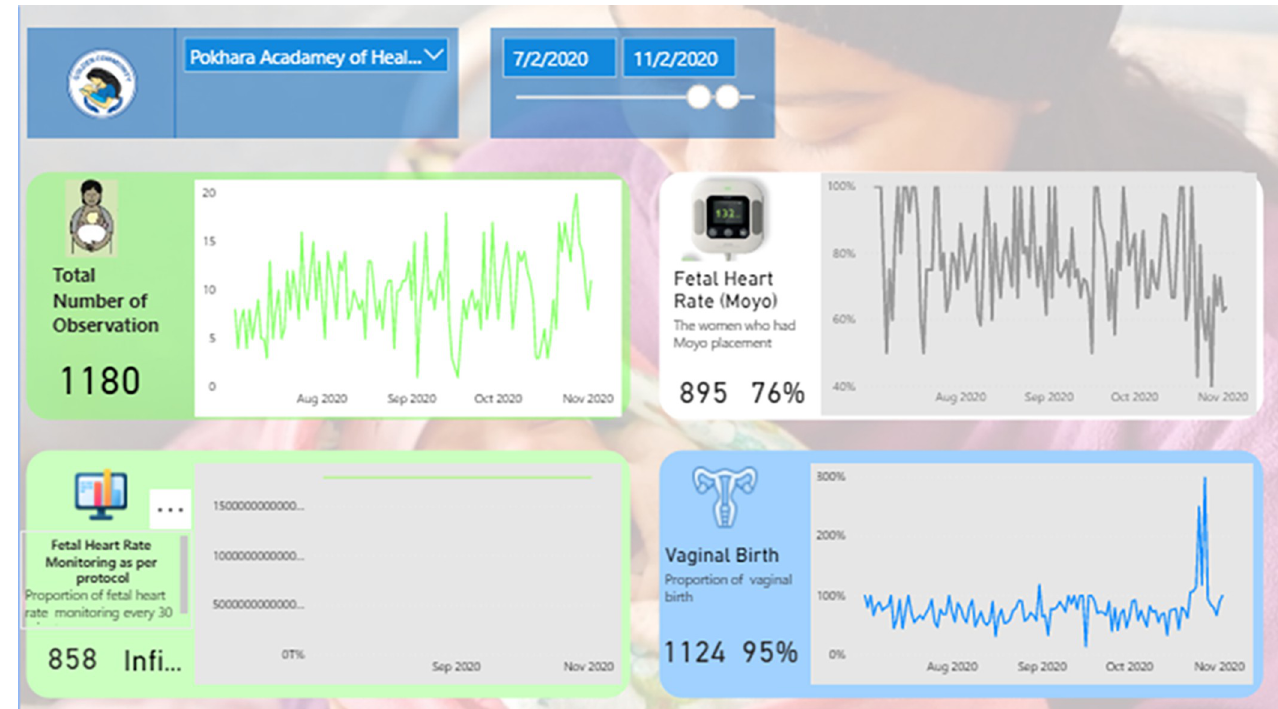
Fig 1. Dashboard developed to maintain key quality